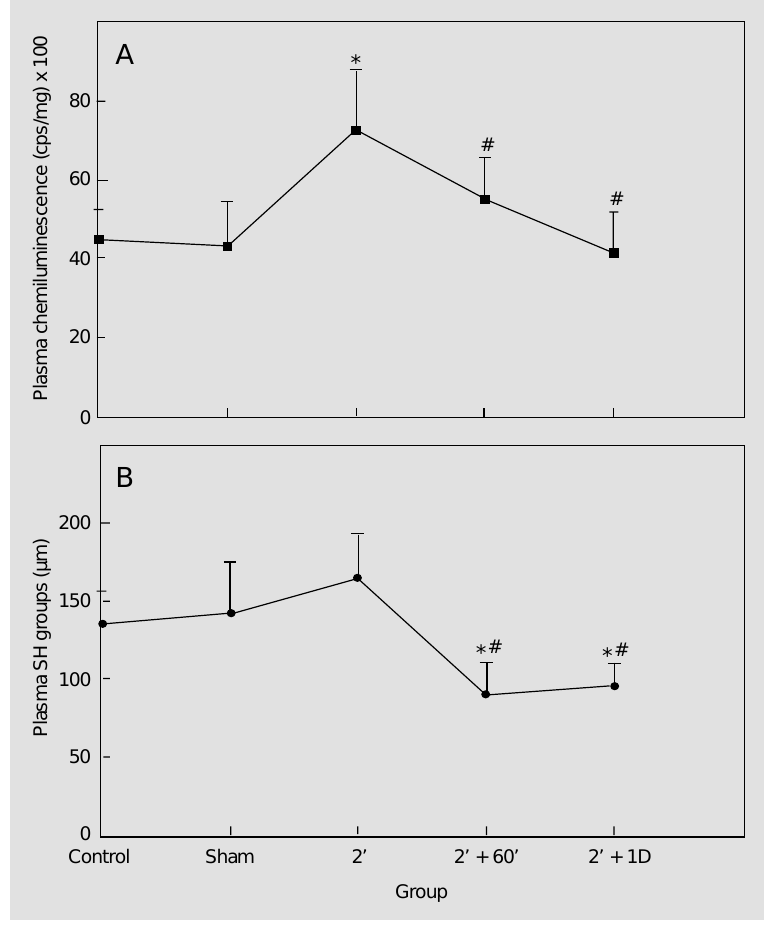
Figure 1 - Effect of 2-min (2') transient forebrain ischemia and reperfusion in rats on tert - butyl hydroperoxide-initiated chemiluminescence of plasma (A) and plasma thiols (B). Rats were submitted to 2-min (2') ischemia followed by 60 min or 1 day (D) of reperfusion. Data represent the mean ± SD for six to nine different animals. *P<0.05 compared to control groups. # P<0.05 compared to the 2-min (2') ischemic group (Duncan multiple range test). SH,